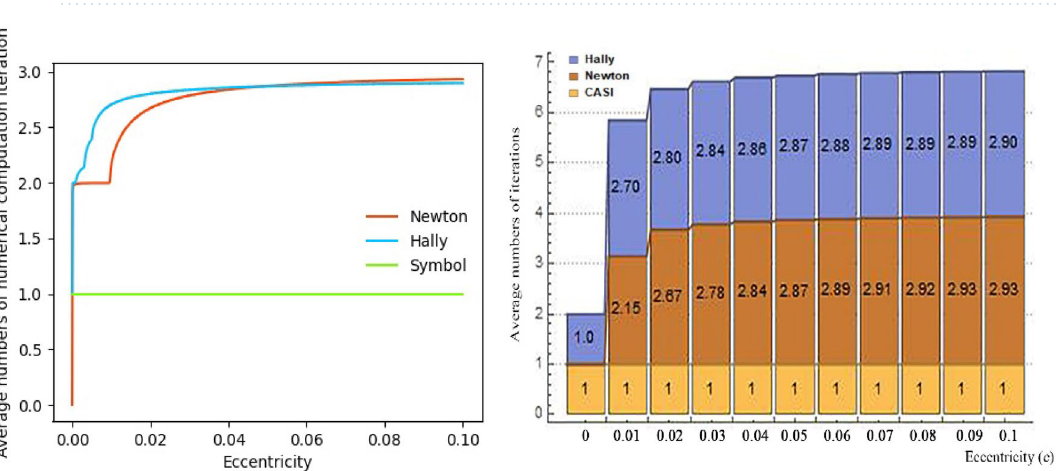
Figure 10. Numerical comparisons among our SICAA method, the standard Newton–Raphson method and the Halley’s method to solve the Kepler’s equation. Errors (left) and CPU times (right, units: second) are averaged with respect to M ∈ [0, π ] .